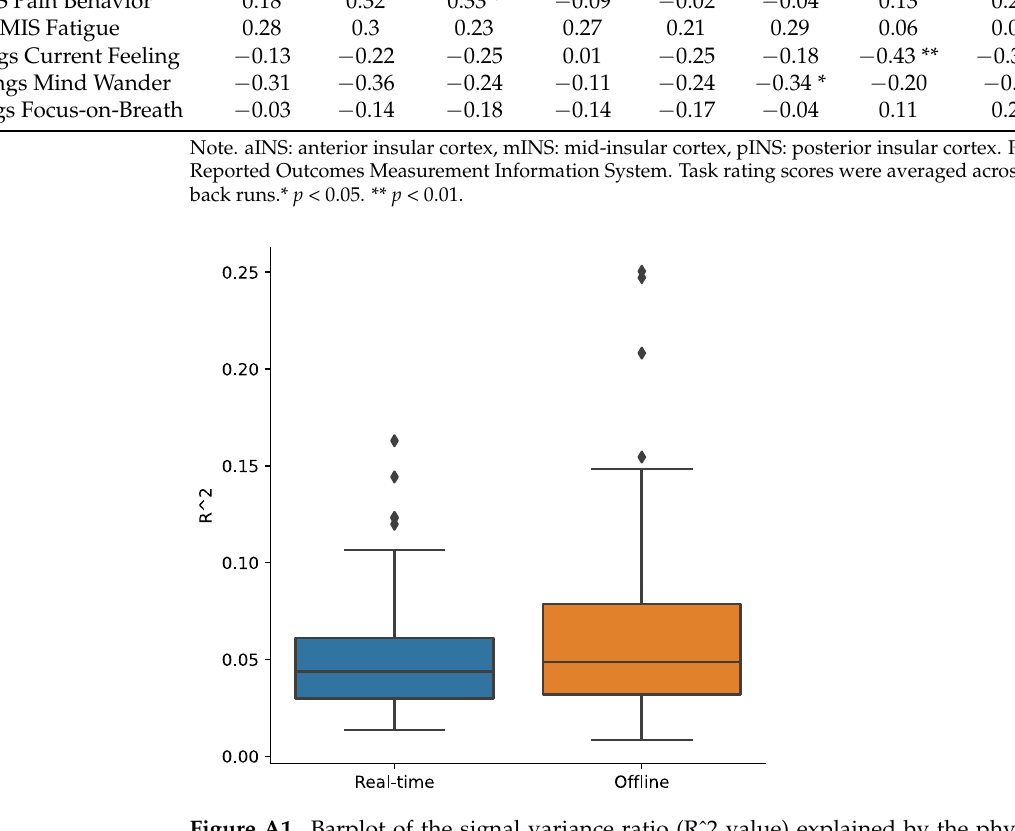
Figure A1. Barplot of the signal variance ratio (Rˆ2 value) explained by the physiological noise regressors (RETROICOR) for the real-time processed and offline processed signals in the PCC region.